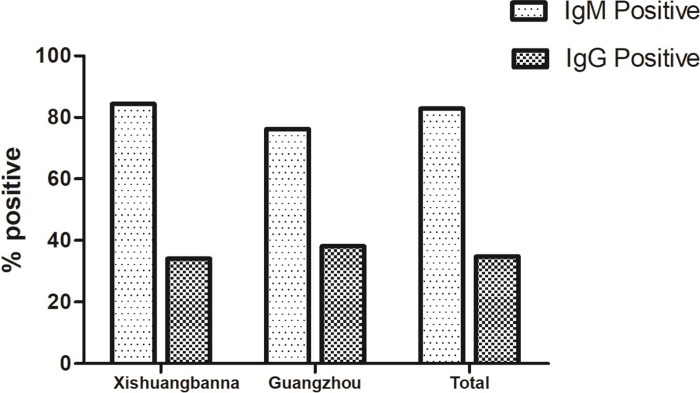
Seroprevalence of DENV-IgG and seroincidence of DENV-IgM antibodies in the patients from Guangzhou and Xishuangbanna of China.